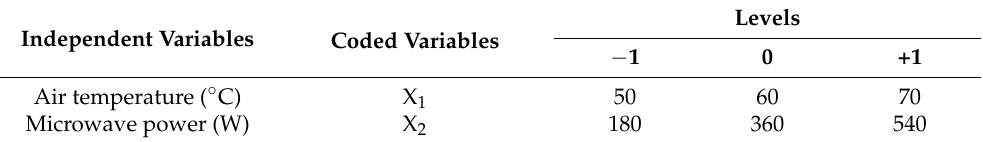
Table 1. Independent variables and their levels.